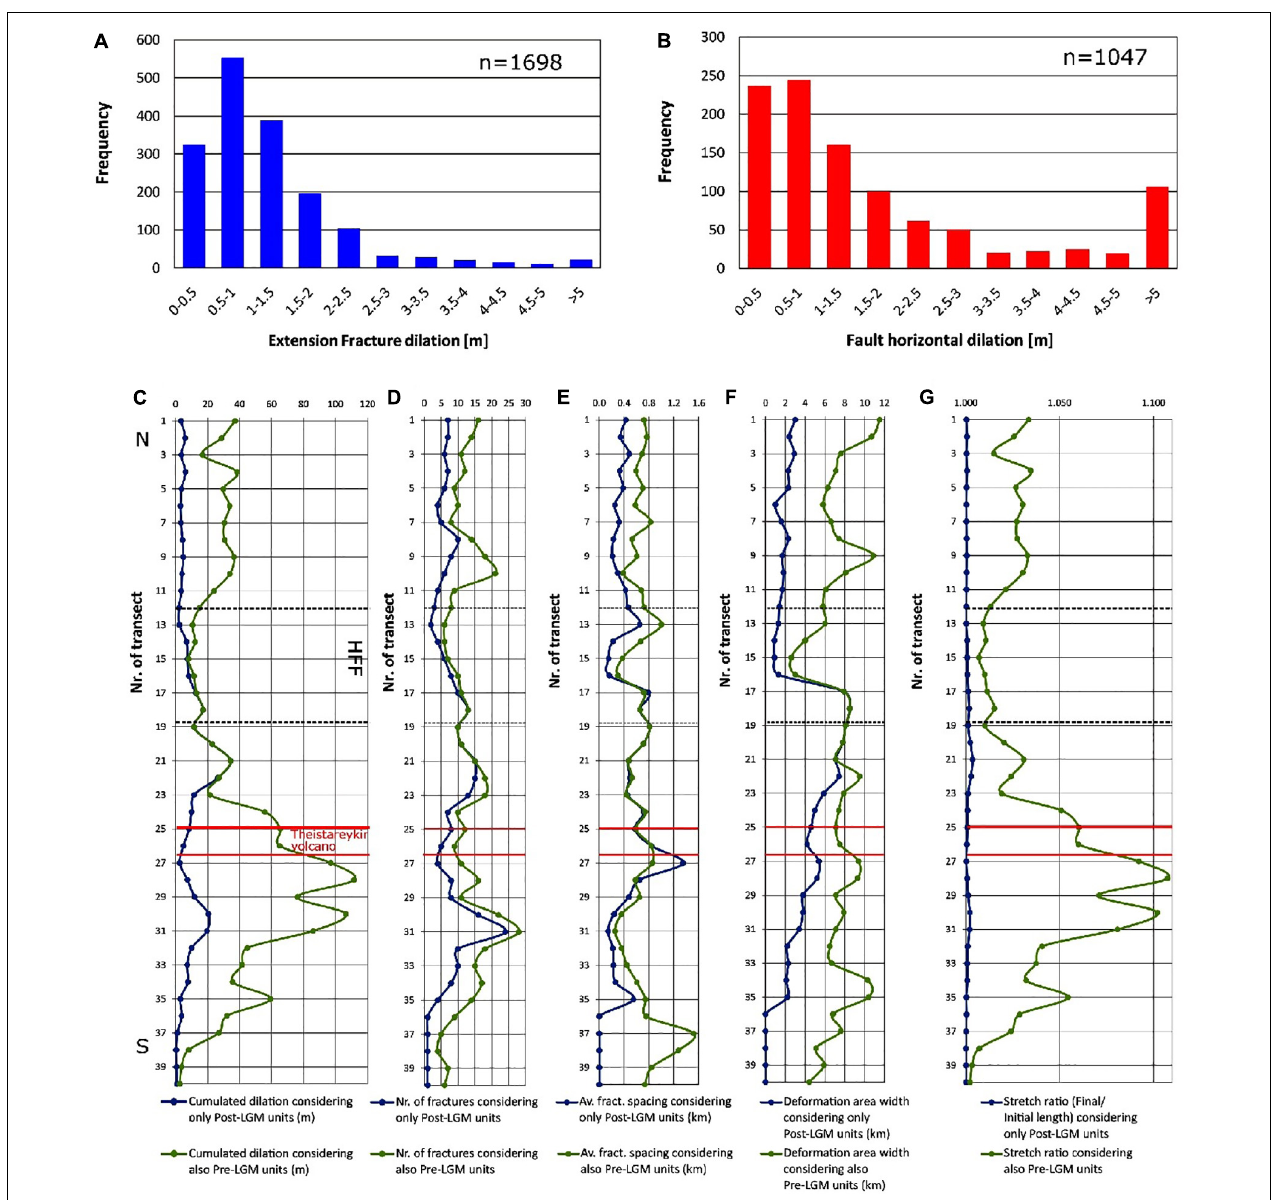
FIGURE 9 | (A) Graph showing the frequency distribution of dilation at extension fractures; (B) graph showing the frequency distribution of horizontal dilation at normal faults; (C) cumulated dilation and (D) number of fractures, (E) average fracture spacing and (F) deformation zone width; (G) stretch ratio, calculated both considering only Post-LGM units and considering also Pre-LGM units along WNW-ESE transects (shown as thin black lines in Figure 8A